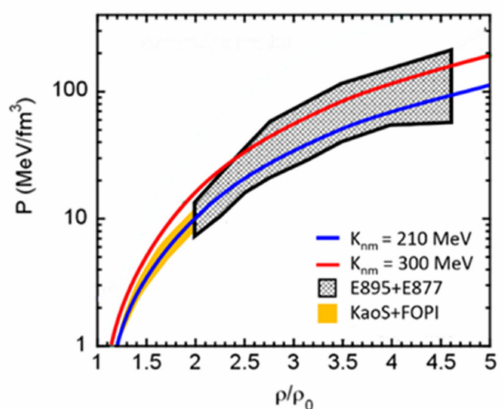
Figure 2. Pressure versus net baryon density for symmetric nuclear matter. Grey hatched area: proton flow data taken at AGS [4,15]. Yellow area: proton flow, fragment flow and kaon data taken at GSI [11–14]. Red line: hard EOS, blue line: soft EOS